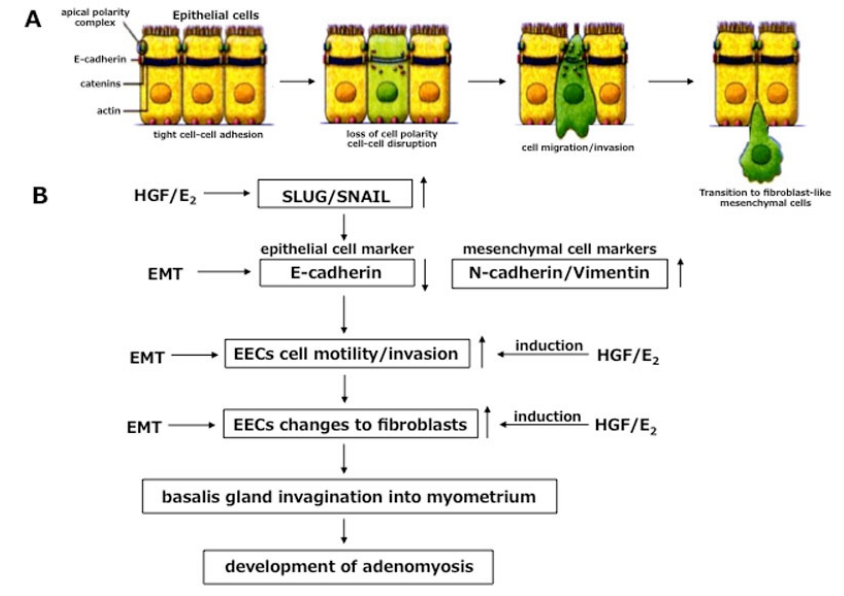
Figure 2. ( A ) Shows cellular aspects of three different components of epithelial ‐ mesenchymal transition (EMT) such as cell ‐ cell disruption, cell migration/invasion and changes of endometrial epithelial cells to spindle ‐ shaped fibroblast ‐ like mesenchymal cells that may be involved in the development of adenomyosis. The revised model of this diagram is extracted from the article of Acloque H et al. [92]. ( B ) A diagrammatic representation showing hepatocyte growth factor (HGF) ‐ and estrogen (E 2 ) ‐ induced pathways in the occurrence of epithelial ‐ mesenchymal transition (EMT) in human adenomyosis. Up ‐ regulation of SLUG and SNAIL, two transcriptional repressors of E ‐ cadherin, in response to HGF and E 2 are associated with decreased expression of E ‐ cadherin (epithelial cell marker) and increased expression of N ‐ cadherin/Vimentin (mesenchymal cell markers) causing disruption of tight cell ‐ cell contact. These cellular events in endometrial cells and in intact tissues trigger morphological changes of endometrial epithelial cells (EECs) to a fibroblast ‐ like mesenchymal phenotype and induce increased cell migration/invasion, two essential components of EMT that induced by HGF and E 2 either alone or in combination. All these events of EMT may be involved in adenomyosis. 4.3. Metaplasia of Müllerian Remnants In addition to the widely accepted invagination theory, adenomyotic lesions may originate de novo from metaplasia of displaced embryonic pluripotent Müllerian remnants. The Müllerian ducts are primordial embryological structures that, during fetal life, develop to form female uterine tract (uterus, fallopian tubes and upper part of the vagina) [95]. These ducts consist of surface epithelium and the underlying urogenital ridge mesenchyme, with the capacity to differentiate into endometrial glands and stroma [96]. It is presumed that metaplastic changes of intramyometrial embryonic pluripotent Müllerian remnants in the adult uterine wall could possibly lead to establishment of de novo ectopic endometrial tissue within the myometrium, resulting in the generation of adenomyotic lesions [2]. The non ‐ infiltrating type of deep endometriotic nodules, which are different from peritoneal endometriosis, may be the consequence of Müllerian rest differentiation, at least in some cases, or the result of an adenomyotic tumoral process originating from the cervix [97,98]. Furthermore, the histological findings of deep endometriotic nodules show identical features of adenomyosis in relation to smooth muscle hyperplasia and fibrosis [97,99]. The Müllerian metaplasia theory is further supported by case reports of confirmed adenomyosis in the rudimentary uterine wall of patients with Rokitansky ‐ Kuster ‐ Hauser syndrome [100,101].